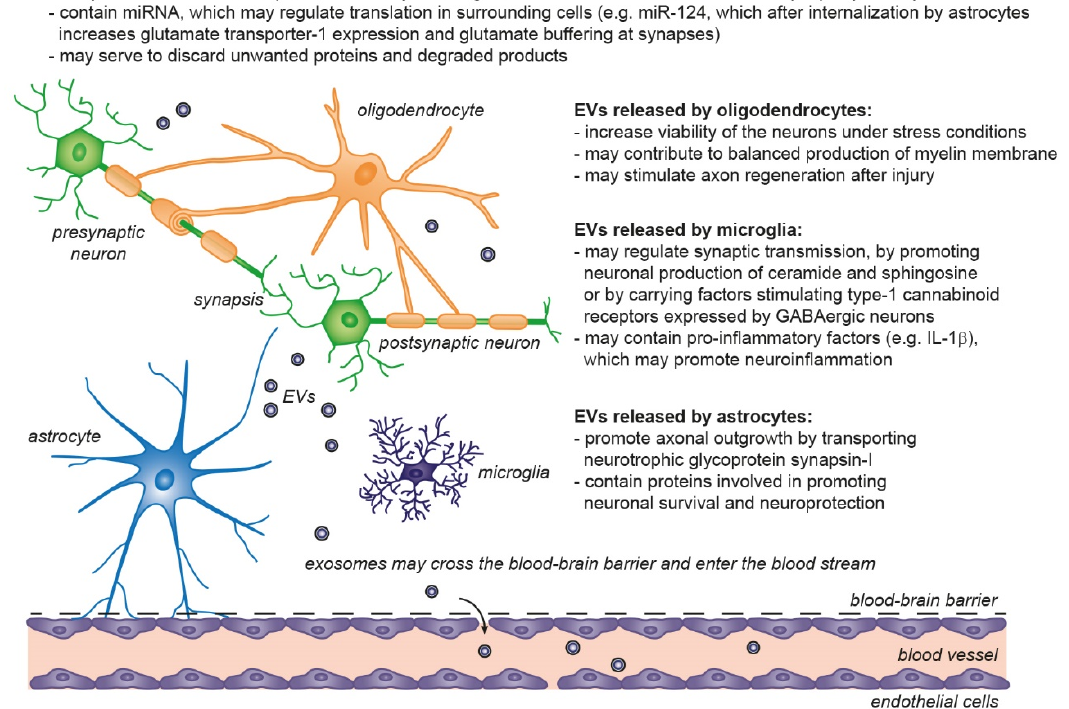
Figure 4. Physiological roles of extracellular vesicles in the central nervous system. EVs released from neurons and glial cells show neurotrophic and neuroprotective effects, by regulation of synaptic transmission/plasticity, protection against stress and excitotoxicity and may support axon regeneration after injury. Astrocytes and microglia participate in removal of EVs produced by other cells and may contribute to degradation of unwanted proteins (including unfolded proteins) released through EVs [86–88,105–107].